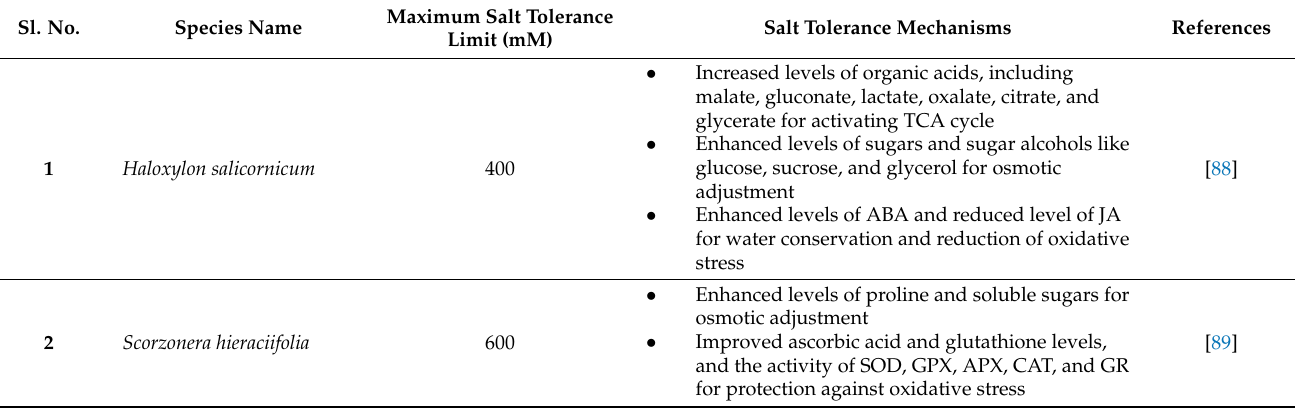
Table 1. List of selected halophyte species along with their adaptive mechanisms favorable for salt tolerance. Sl.